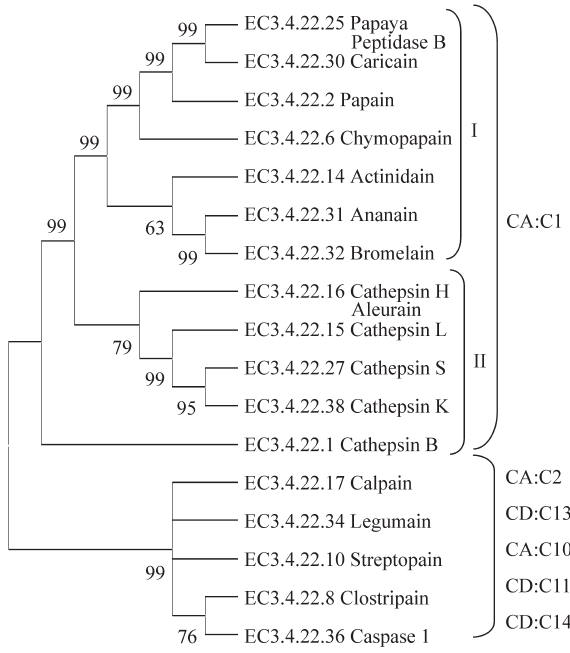
Figure 1 - A phylogenetic unrooted tree of standard members of the cysteine proteinases E.C.3.4.22 sub-sub-class. The tree was constructed using MEGA software with the following parameters: p-distance, neigh- bor joining, pair-wise deletion, and internal branch with 5000 replications. The analysis was based on the MAP alignment of the 17 sequences. The values obtained from internal branch replication are indicated at the main branch